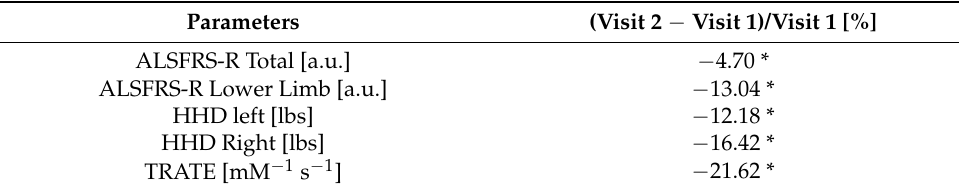
metric (TRATE) as percent change in recorded value between visits.